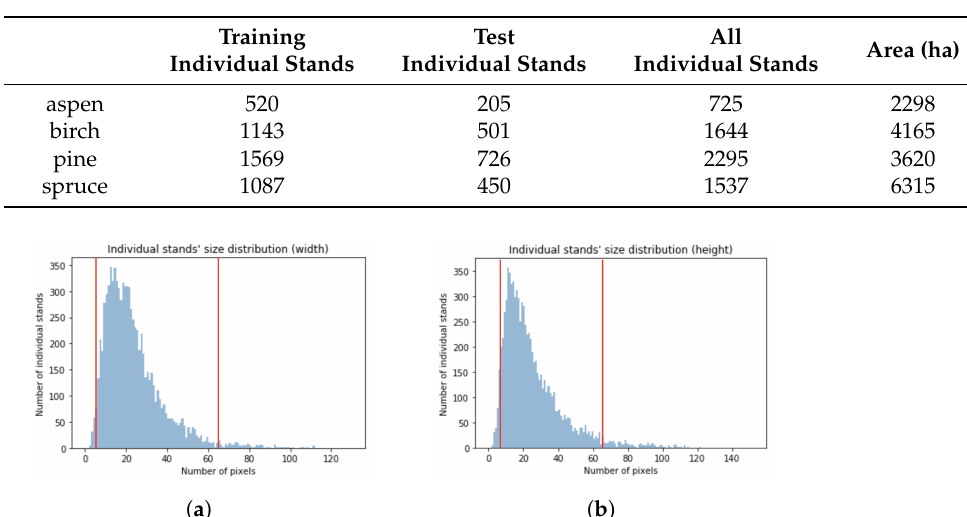
Table 1. Dataset statistics.